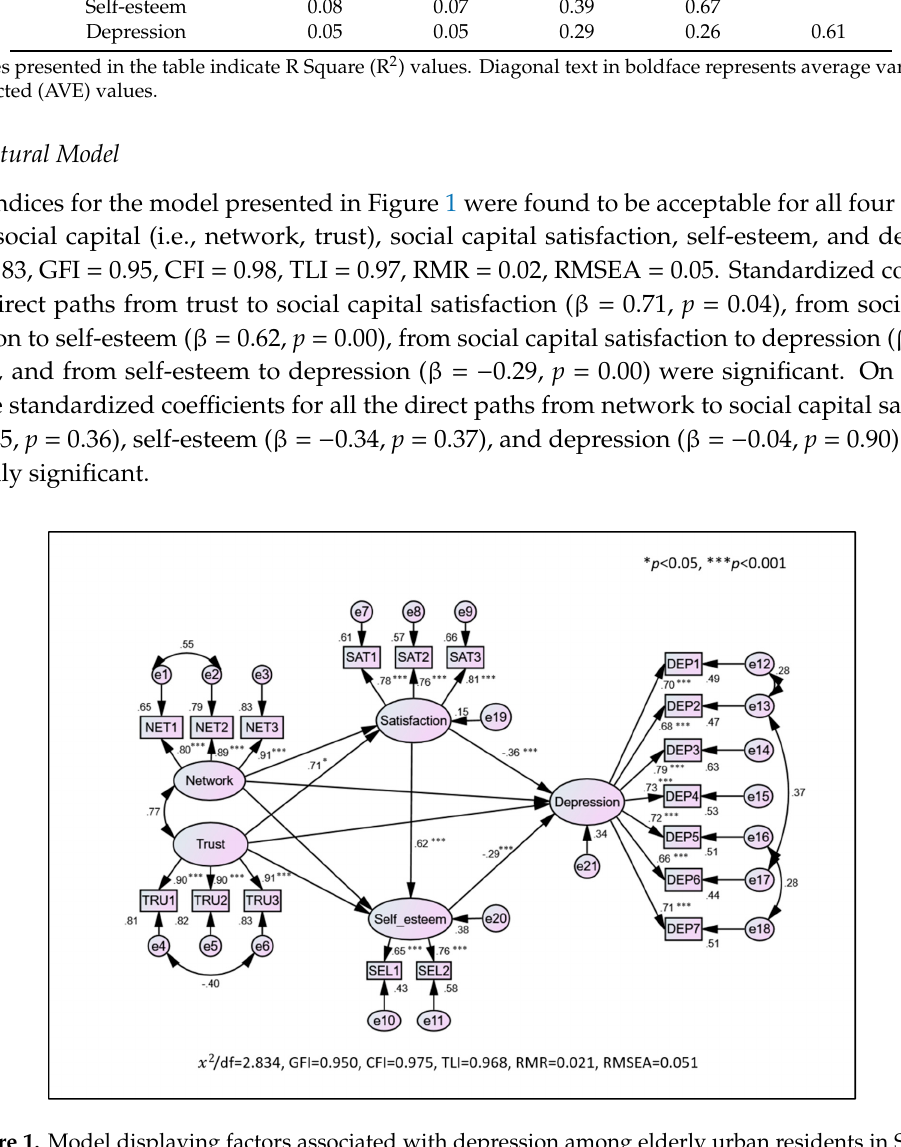
Figure 1. Model displaying factors associated with depression among elderly urban residents in